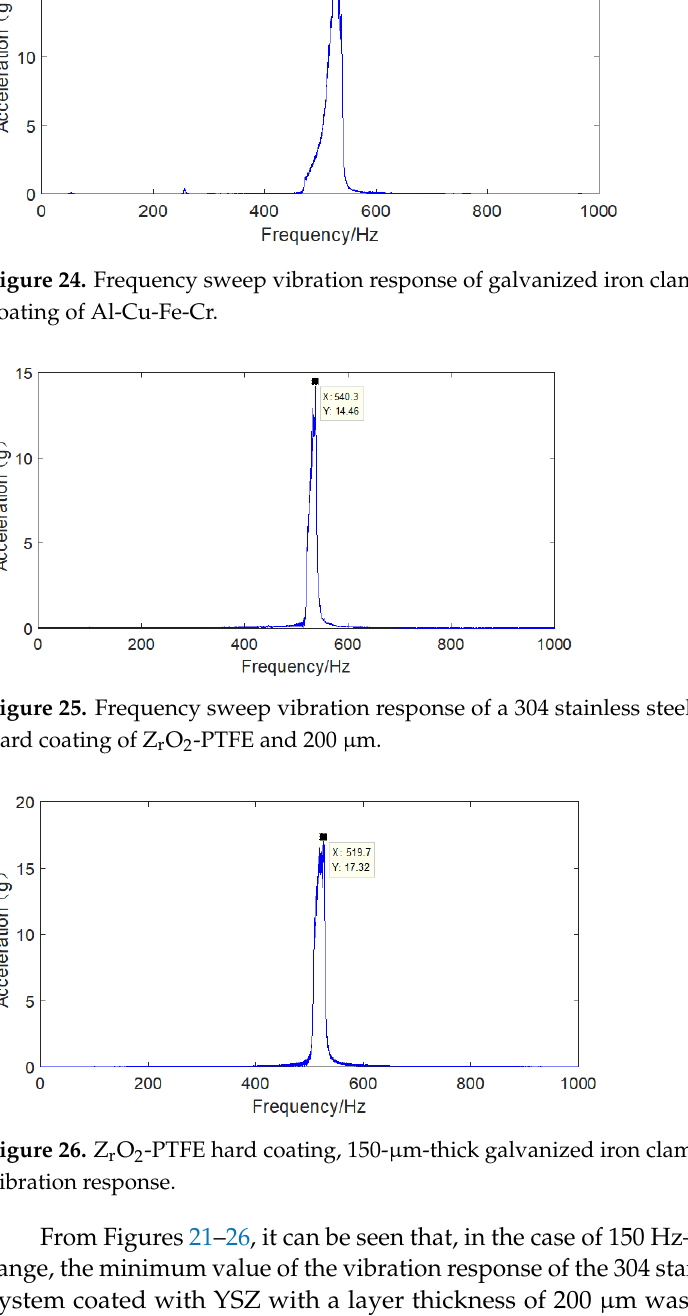
Figure 23. Frequency sweep vibration response of 304 stainless steel clamp with a 200- μ m-thick hard coating of 8% Y 2 O 3 -Z r O 2 .